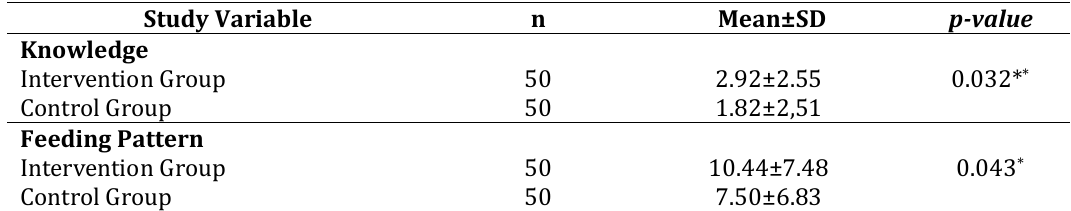
Table 3 Comparison of Knowledge Level and Feeding Pattern in Children Aged 0-24 Months Before and After the Intervention in the Intervention Group and the Control Group (Between Group Comparison) Study Variable n Mean±SD Knowledge Intervention Group Feeding Pattern Intervention